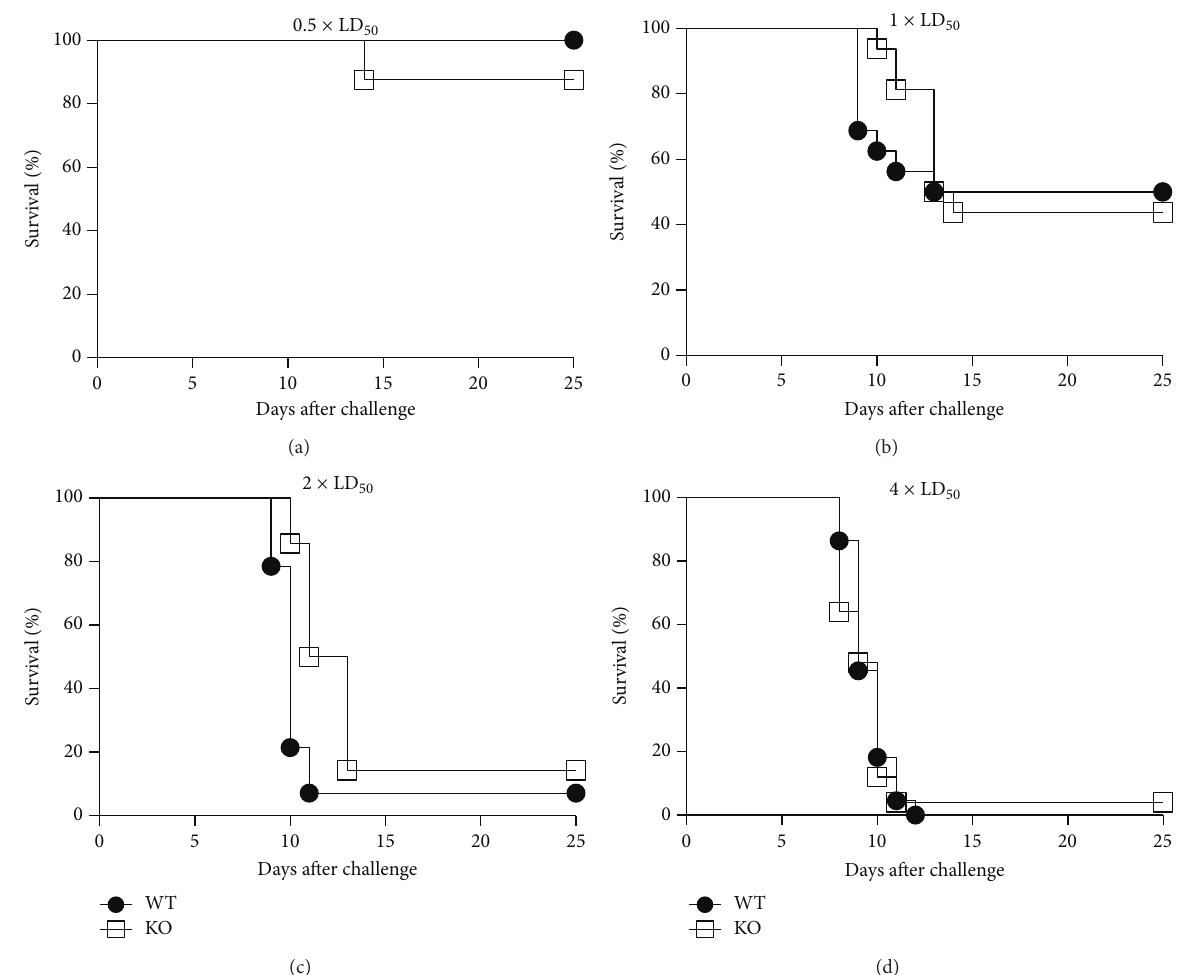
Figure 1: There is no difference in survival of naive Fc 𝛾 RIIB KO versus na¨ıve WT mice challenged with Ft -LVS. Na¨ıve WT C57BL/6J and Fc 𝛾 RIIB KO mice were challenged i.n. with 0.5 × LD 50 (a), 1 × LD 50 (b), 2 × LD 50 (c), or 4 × LD 50 (d) of Ft -LVS and survival was monitored for 25 days after challenge. Panel (a) represents 8 mice/group while panels (b)–(d) represent between 14 and 25 mice/group. Statistical